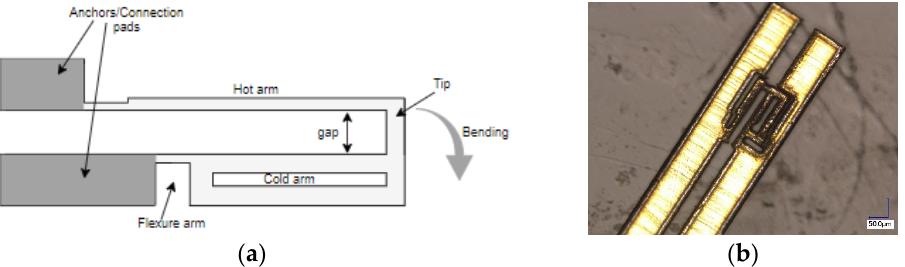
Figure 21. Design E having two cold arms connected at the base: ( a ) schematic diagram; ( b ) laser cut-out of the corresponding actuator.